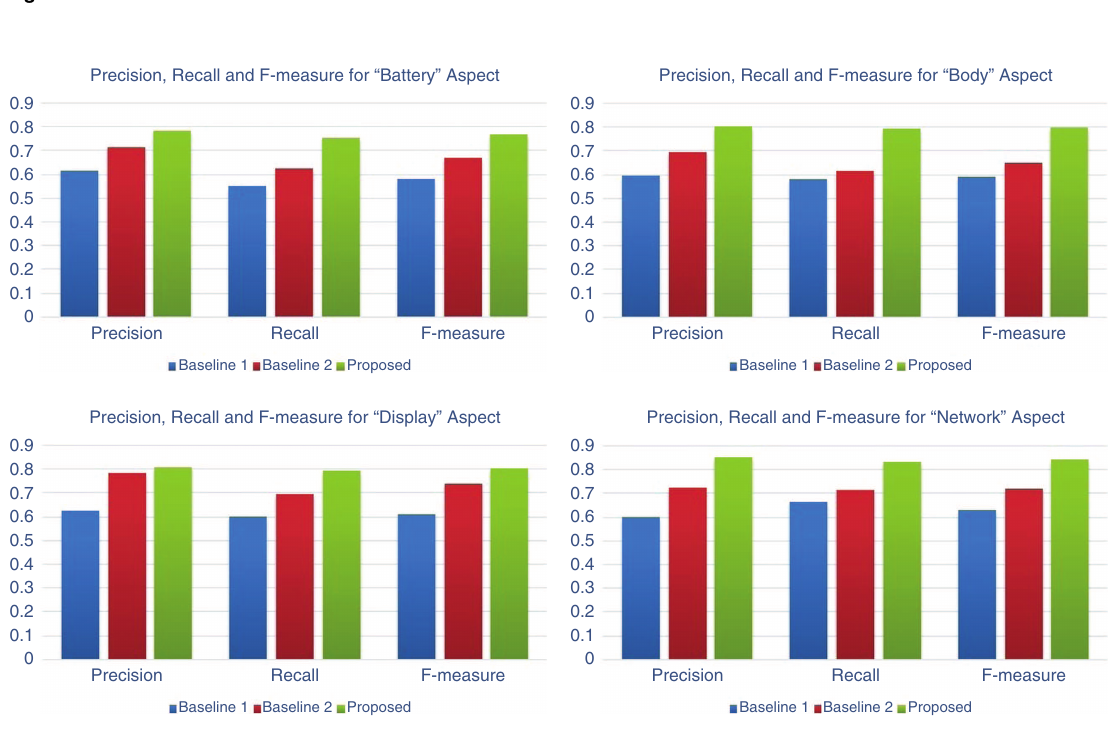
on real-time data. The current screenshot shows the result of aspect-based sentiment analysis for the mobile Xiaomi Redmi Note 3, and the corresponding user reviews are collected from the famous customer review platform called MouthShut. Our proposed algorithms could clearly show the user sentiments on different aspects of the mobile, and the algorithms were found to be highly scalable. This system has already been implemented for some e-commerce vendors, and they are using it as a pilot